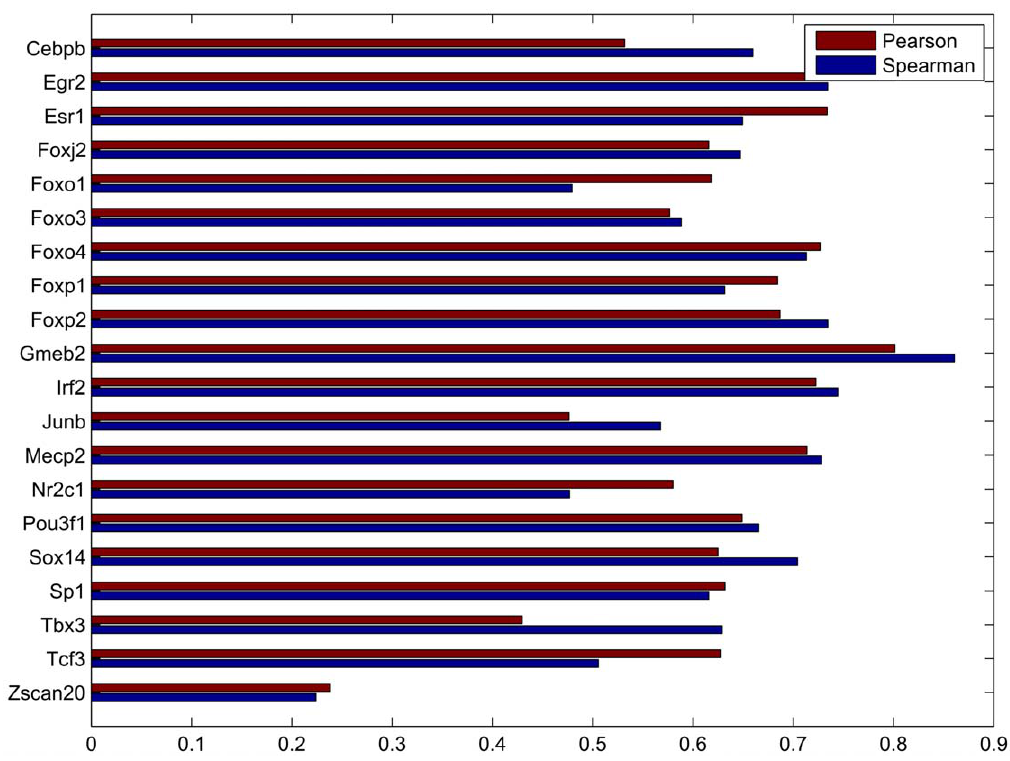
Figure 9. Pearson and Spearman correlations between the predictions of our method (HK R ME) and measured intensities on the ME array. Due to space constraints, results are only shown for the first 20 TFs. Results for all TFs are provided in supplementary Tables S1 and S2.